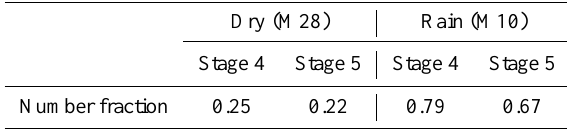
Table 2. Number fraction of bioparticles on MOUDI stages 4 (3.2– 5.6µm) and 5 (1.8–3.2µm) of aerosol samples collected during a dry period (M28) and a rain event (M10). See SOM Sect. S1.4.1.1 for sampling dates. Estimates based on fluorescence microscopy.